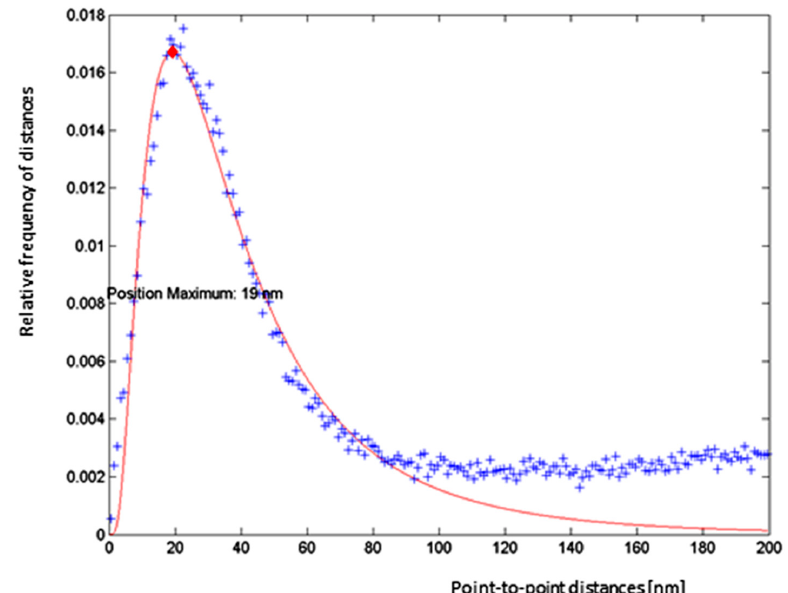
Figure 8. Example of a distance frequency distribution obtained for γ H2AX labelling tags in an SkBr3 cell nucleus of the control (no NPs) specimen exposed to 0.5 Gy of X-rays. In all cases independent of the treatment, compatible distributions were obtained, indicating a characteristic non-random distance distribution. (blue crosses: number of measured distances; red diamond: peak maximum; red curve: fit